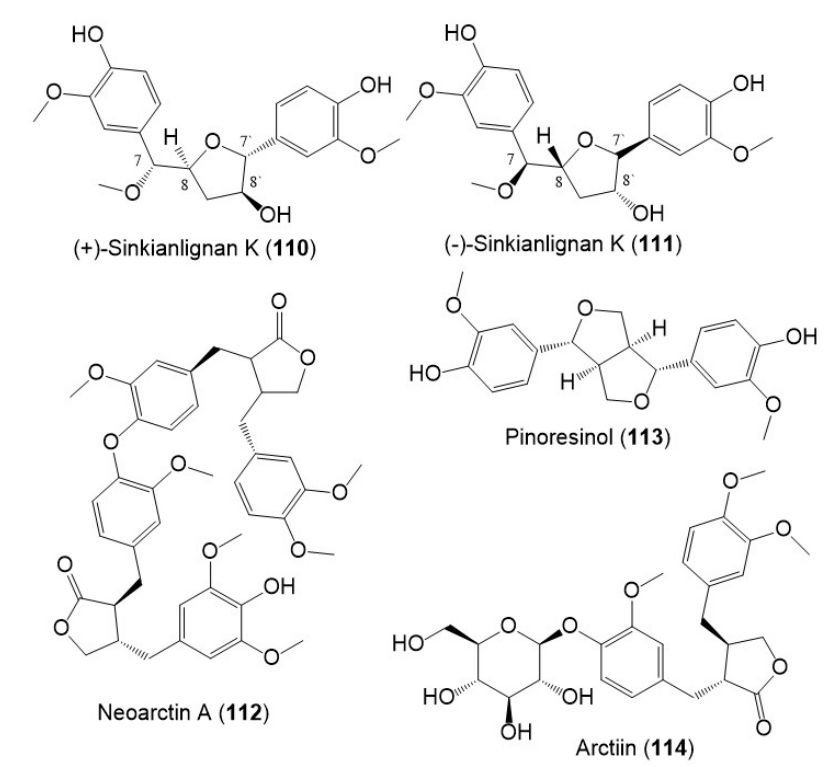
Figure 14. Structures of lignans ( 110 – 114 ) reported from F. sinkiangensis .